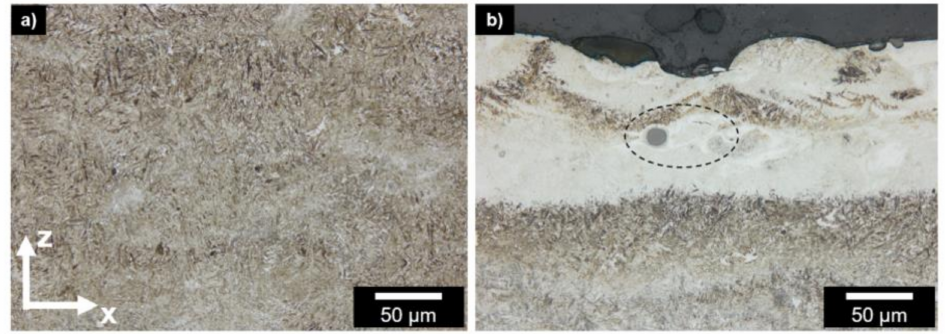
Figure 4. Comparison of resulting microstructure, ( a ) result with graphite powder 1 at 0.5 wt.% C, ( b ) result with glassy carbon powder at the top layer with marked particle and crack at 0.5 wt.% C; z indicates the build direction.